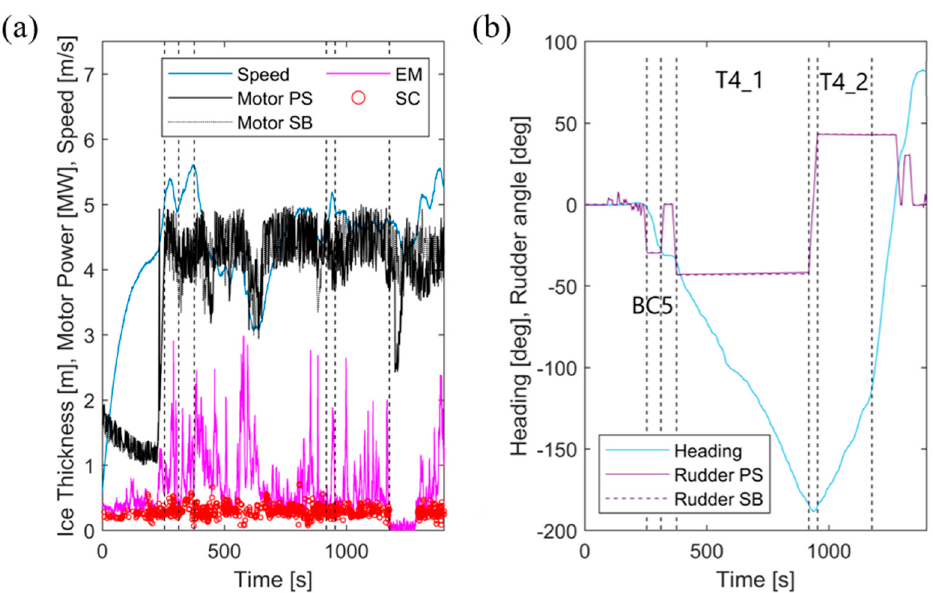
Figure 8. ( a ) Applied motor power, measured ice thickness with the electromagnetic device (EM) and stereo camera system (SC), and obtained speed, and ( b ) applied rudder angles with obtained heading during tests BC5, T4_1, and T4_2.